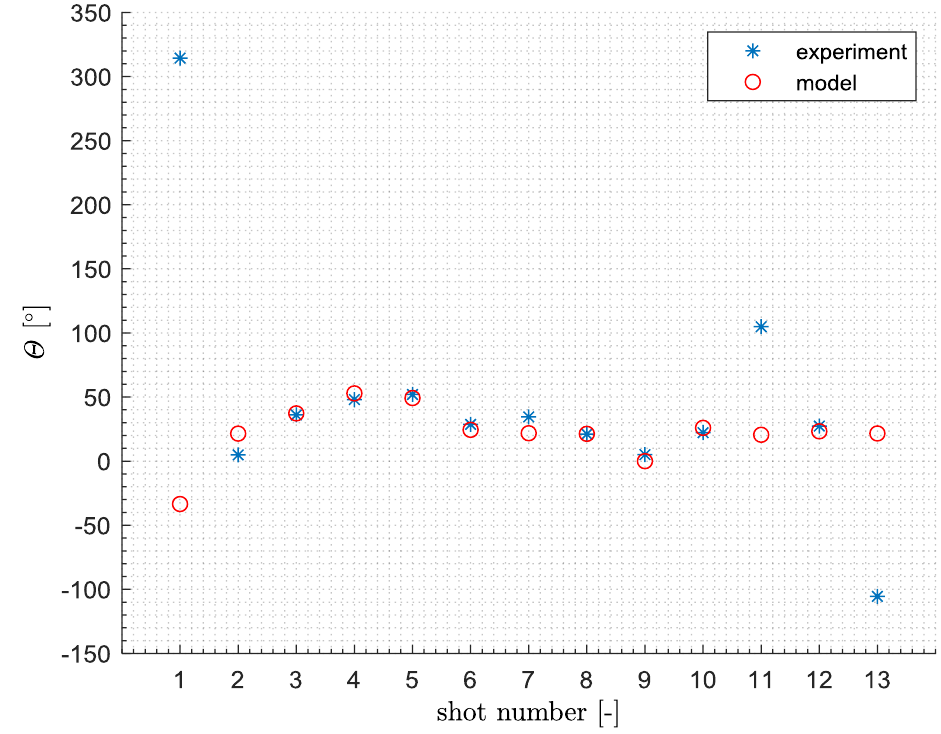
Figure 30. Dispersion of pitch angles at main motor firing (obtained from video footage and numerical simulation).